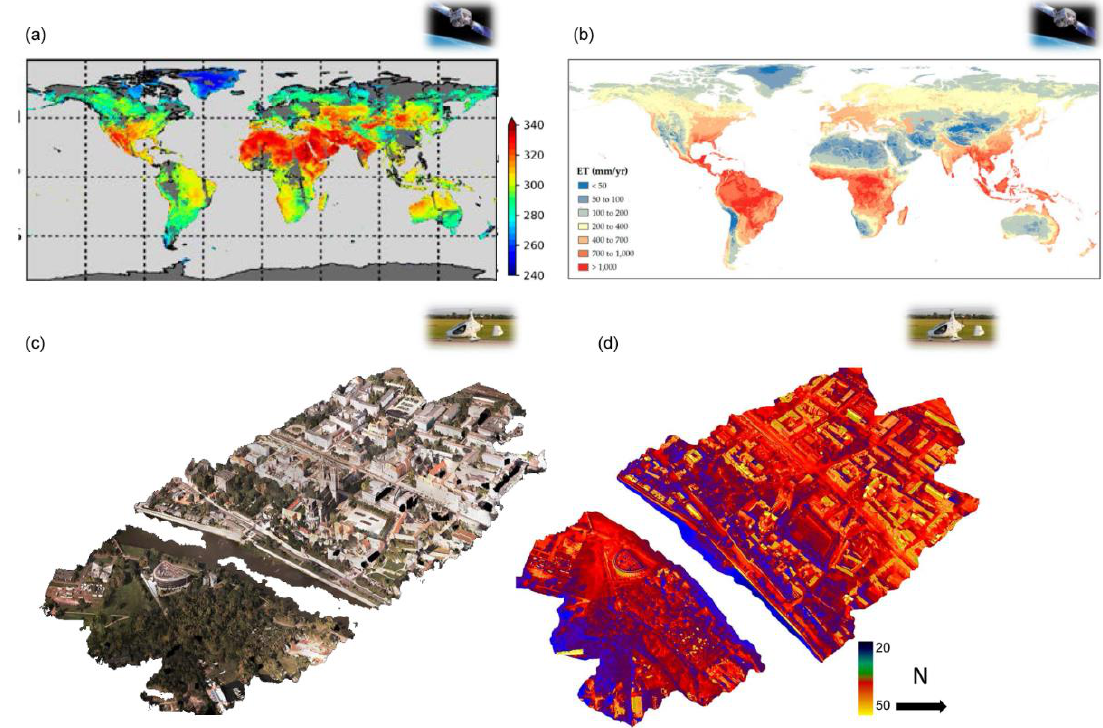
Figure 11. Land surface temperature and related traits: ( a ) Daytime land surface temperature (LTS) composite. Derived from Aqua MODIS RS data for 1 June 2010 (from Ghent et al. [385]), ( b ) daily global evapotranspiration using Menman–Ponteith equation and remotely sensed land surface temperature (Raouf and Beighley, [386]). ( c ) Near 3D-True-Ortho-RGB image of Magdeburg (City Centre) RGB image, ( d ) 3D–TIR image based on the Aerial Oblique System [AOS-Tx8] with 8 cameras (4 cameras FLIR A65 SC, 4 RGB cameras Baumer VC XG-53c) rendered as a 3D TIR image of Magdeburg. ( c , d ) were taken by Prof. Lutz Bannehr, Department of Architecture, Facility Management and Geoinformation, Institute for Geoinformation and Surveying, Dessau,